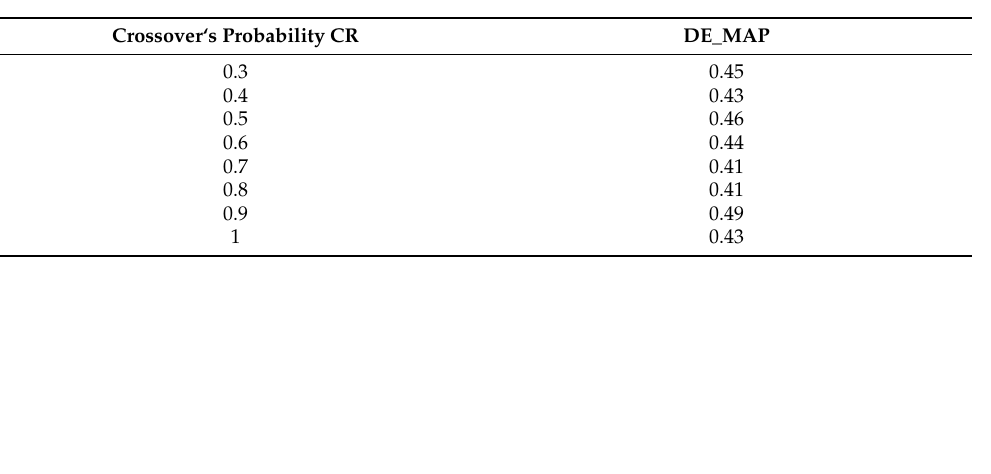
Table 6. CR parameter tuning. This table presents MAP@10 for different parameter values. The remaining parameters are set to the default values according to Table